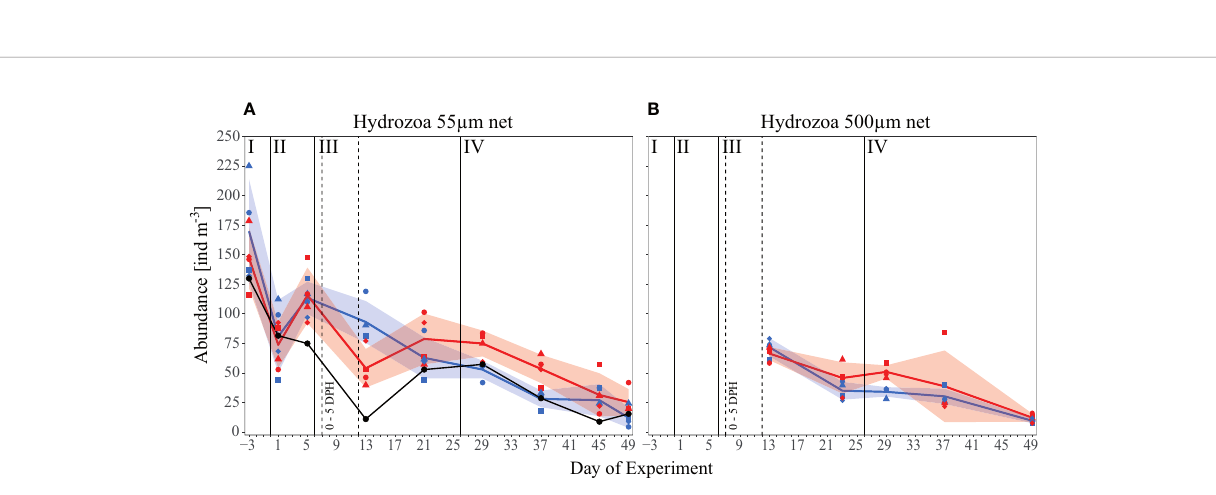
FIGURE 5 | Abundance data [ind m -3 ] of all observed Hydrozoa over the time of the experiment. (A) The small 55 μm mesh size net and (B) the big 500 μm mesh size net. Black line and symbols represent values measured in the surrounding fjord. Other lines, symbols, and colors as described in Figure 1C and Figure 2 .